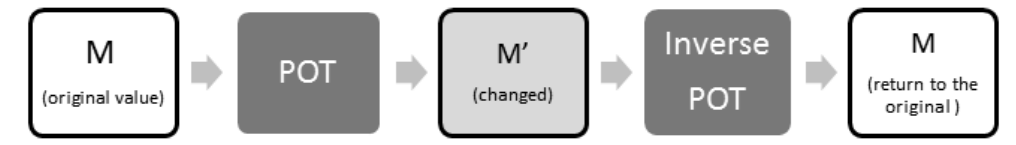
Figure 5. The “reversibility” of POT (and